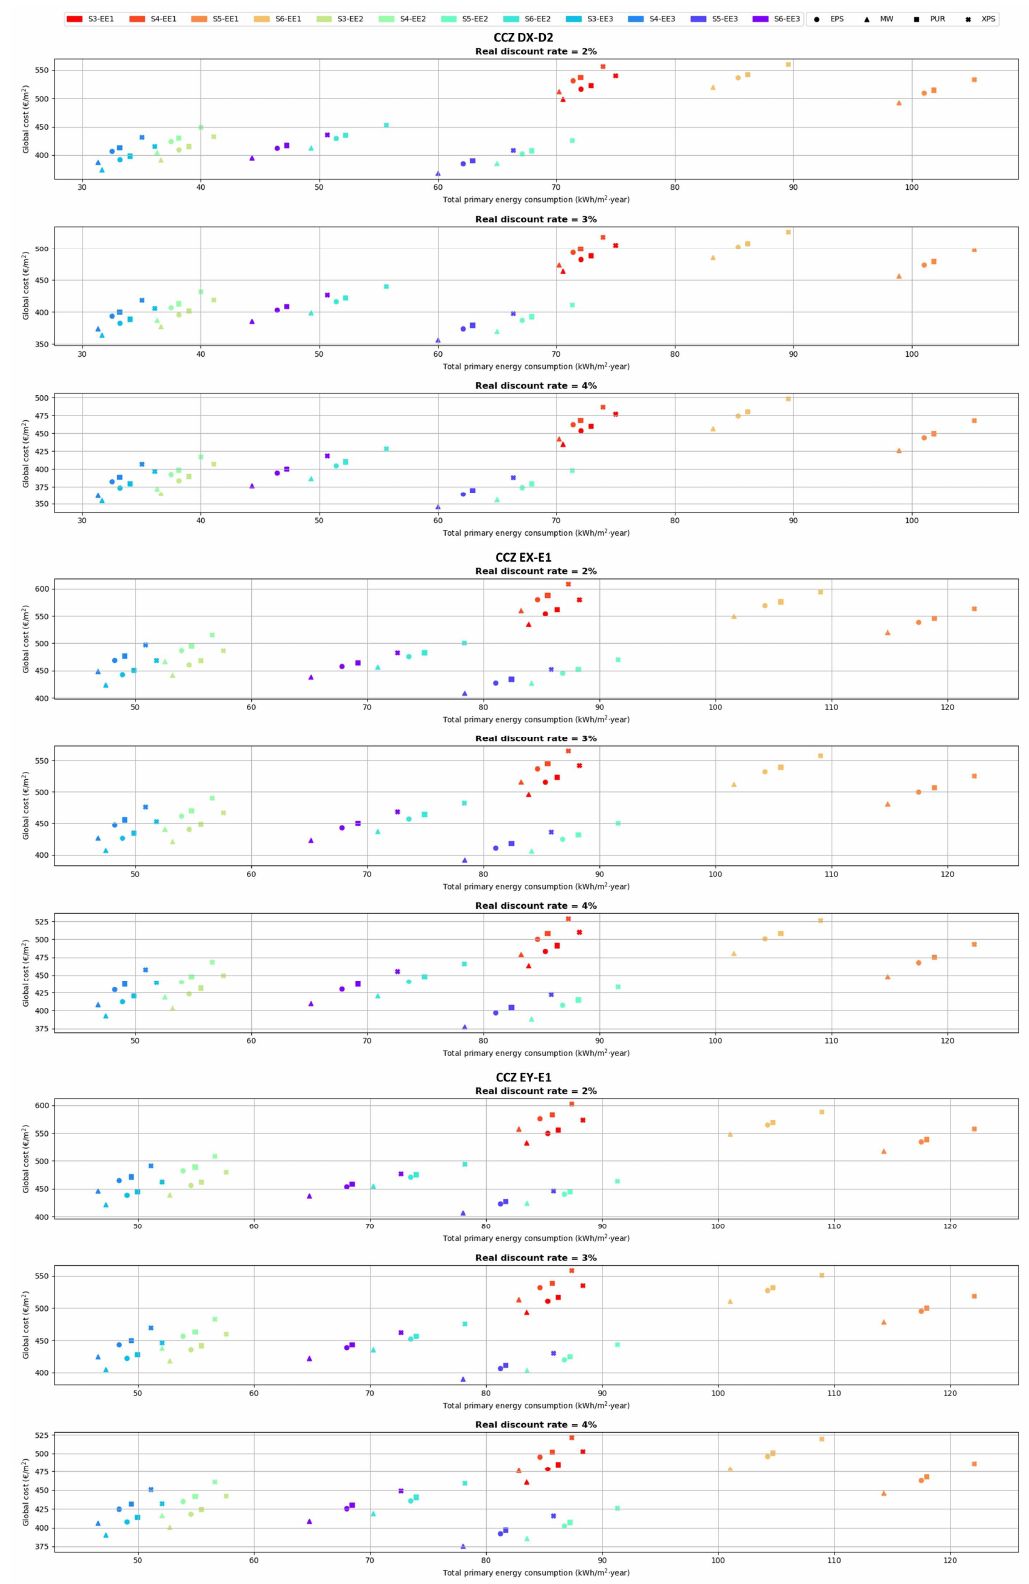
Figure 9. Global cost at the three real discount rates, in EUR/m 2 , versus total primary energy consumption, in kWh/m 2 ·year, for all the energy renovation solutions in each CCZ.